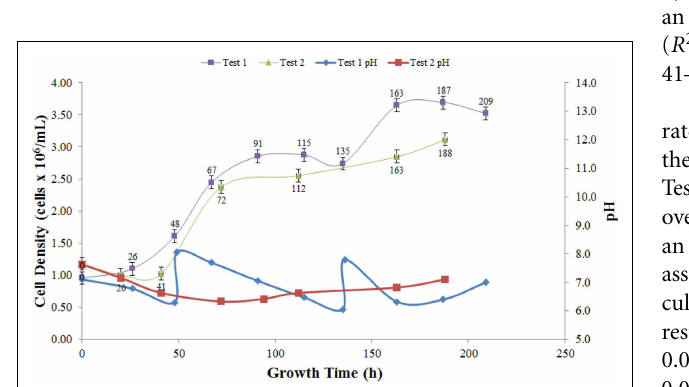
FIGURE 6 | (A) Cleaning action of the bubbles when using Botanicare® as the growth media. (B) Presence of bio fouling when using Bristol media.